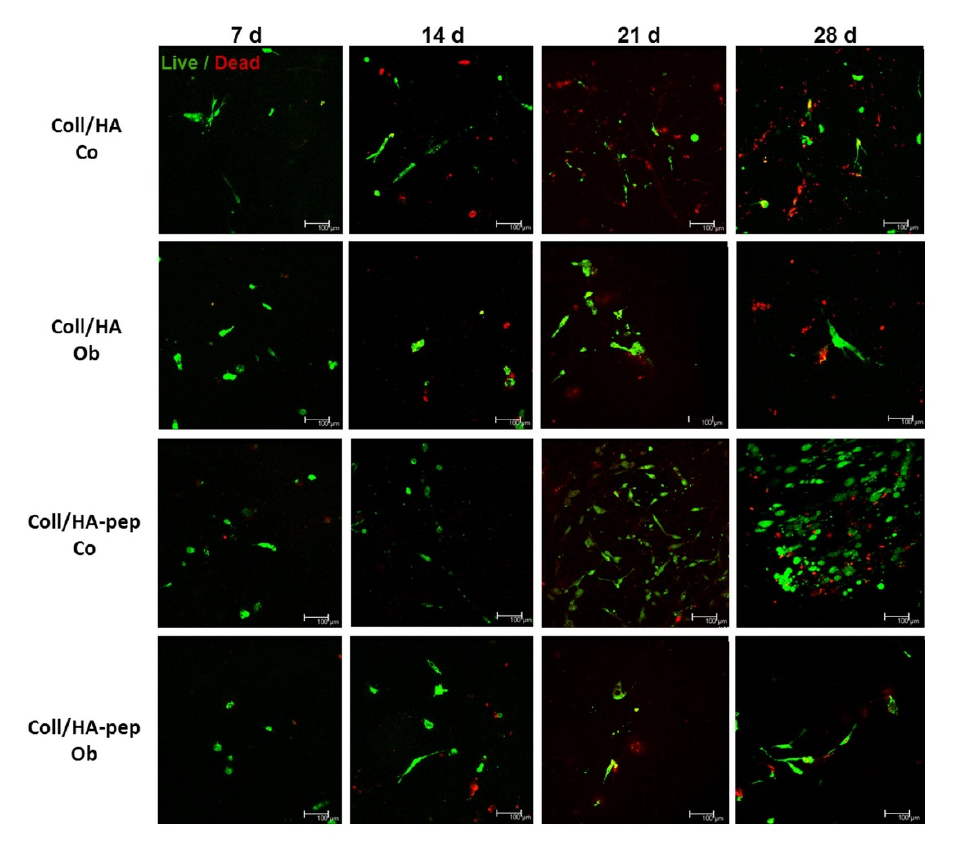
Figure 9. Live/dead staining of JPCs growing within collagen/HA (1:2) composites for different examination time points. JPC viability within collagen/HA (1:2) scaffolds was visualized by a fluorescent live/dead staining. Green fluorescence indicates intracellular esterase activity (living cells) and red fluorescence with ethidium-homodimer 1 indicates the loss in plasma membrane integrity (dead cells). The incorporation of E7 BMP-2 mimicry peptides promotes the long-term survival of seeded JPCs in particular under normal conditions (after 21 and 28 days of cultivation).